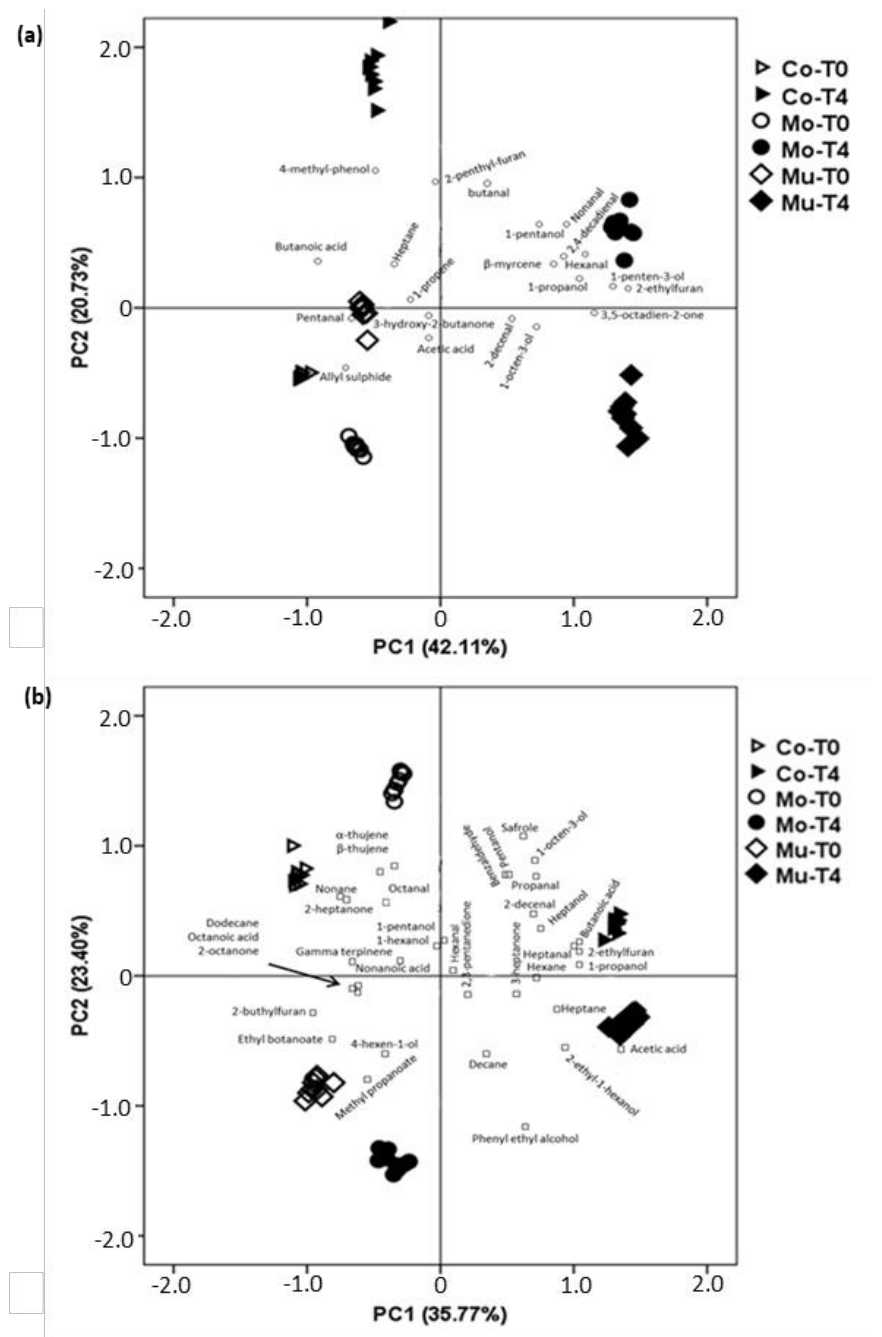
Figure 4. Bi-plot of principal component analysis (PCA) of volatile compounds in dry-cured ( a ) and cooked ( b ) sausages. Co: control batch; Mo: batch with added monolayered fish oil microcapsules; Mu: batch with added multilayered fish oil microcapsules; T0: batch sampled before storing; T4: batch sampled after storing for four months.